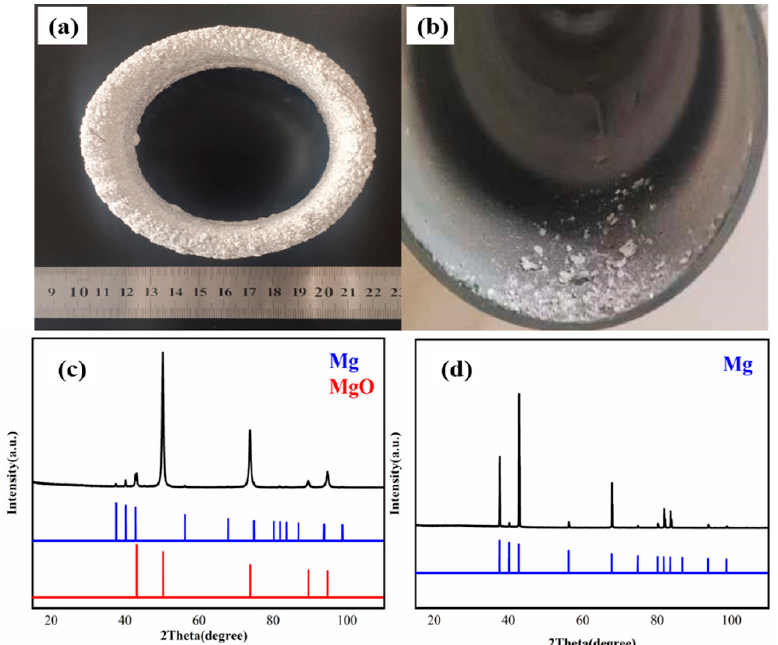
Figure 7. ( a ) Photograph of the distilled Mg collected on the condenser, ( b ) photograph of the residue after Mg distillation, ( c ) XRD patterns of the CM before distillation, and ( d ) XRD patterns of the distilled substance.